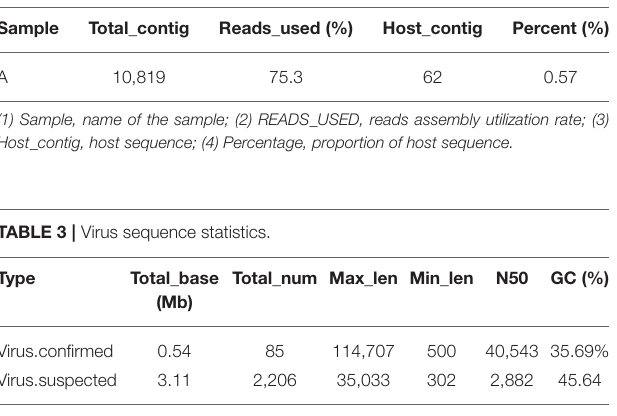
FIGURE 3 | Statistics of the results of horizontal annotation of the viral family. Note: (1) Species with proportion of reads > 1% were selected for display; proportion of virus = number of single virus reads/number of total virus reads × 100.